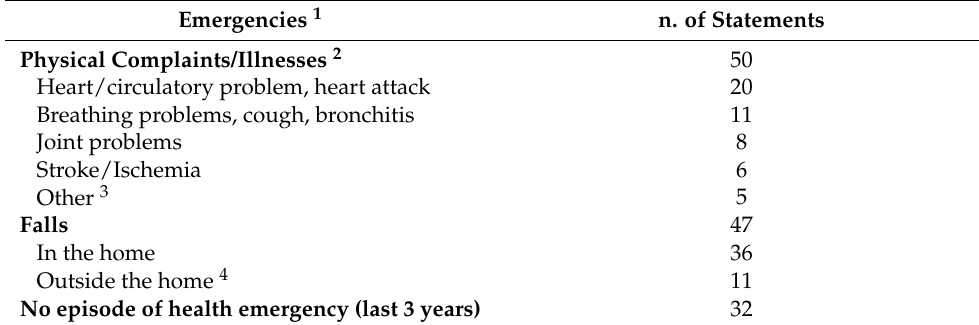
Table 3. Health Emergencies in the last three years (at least one episode).